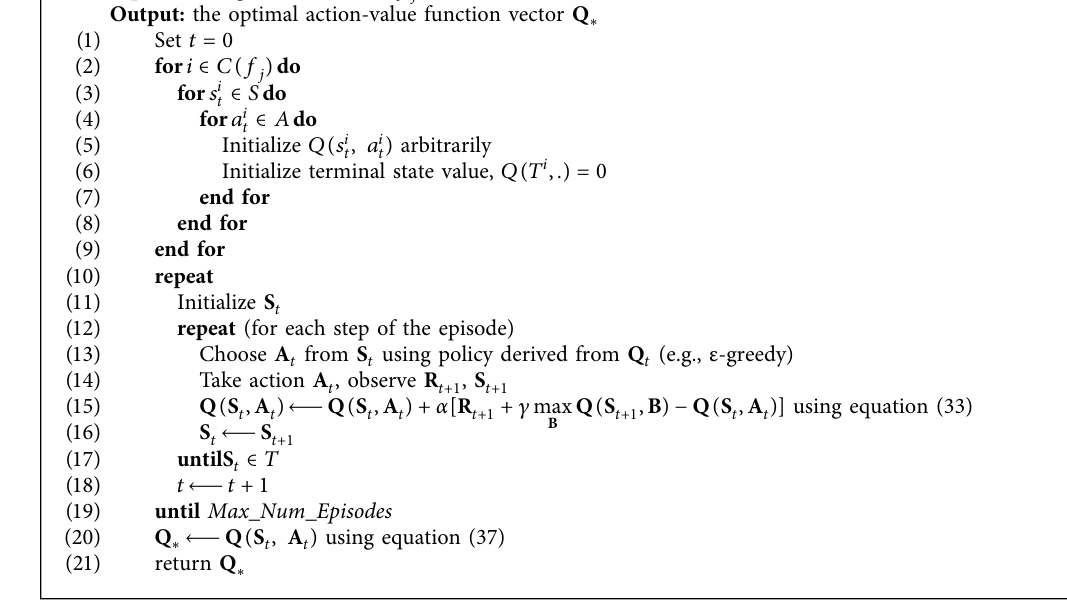
A LGORITHM 1: Pseudocode of the Q-learning for the ofoading problem.